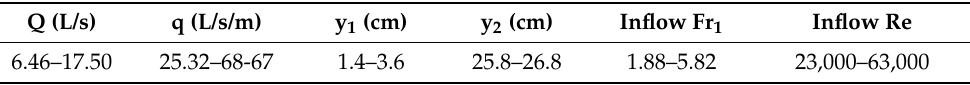
Table 1. Range of initial parameters of supercritical flow upstream of the step. Q (L/s) q (L/s/m) y 1